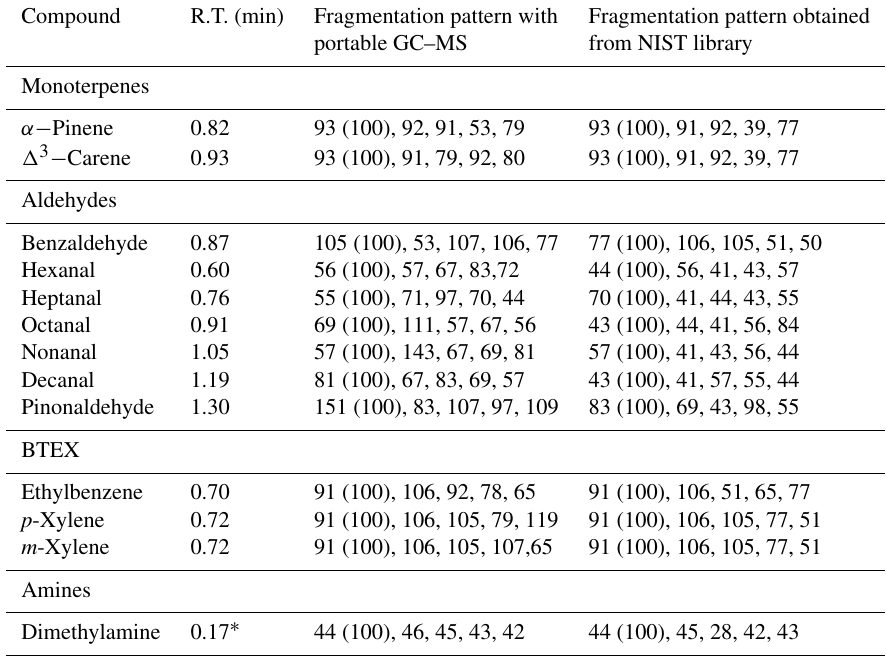
Table 1. Retention times and most abundant fragments (in order of descending intensity) obtained by portable GC–MS for the identified